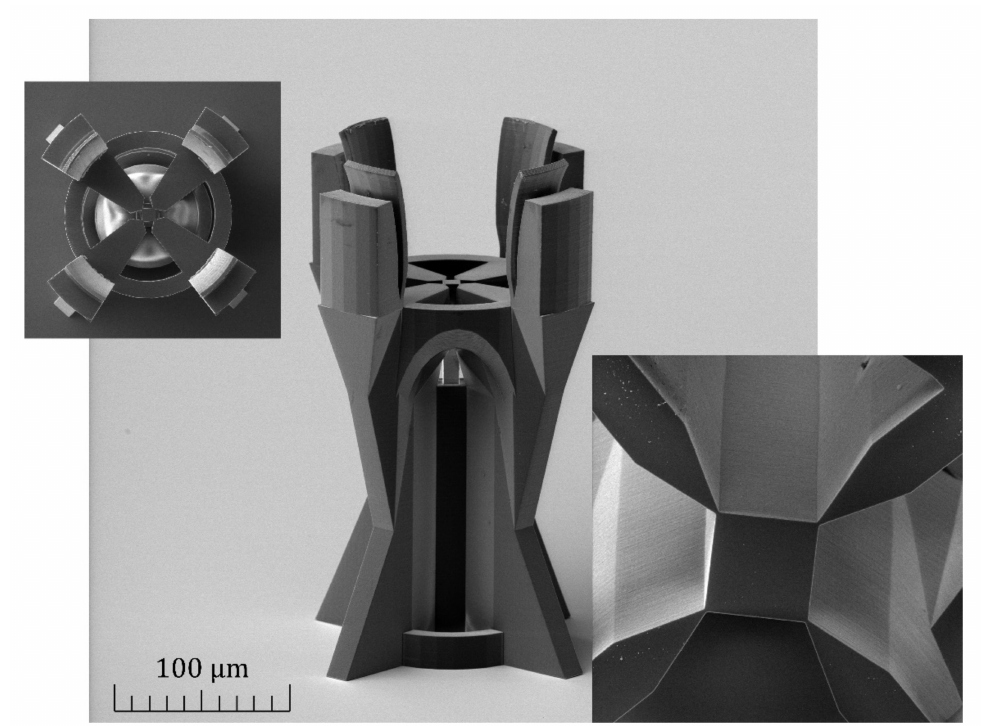
Figure 5. SEM image of the 3D 1 × 4 MMI splitter, prepared from IP-Dip polymer, with inserted images of top view from output side (top left) and detail of output MMI part coupled to support- ing